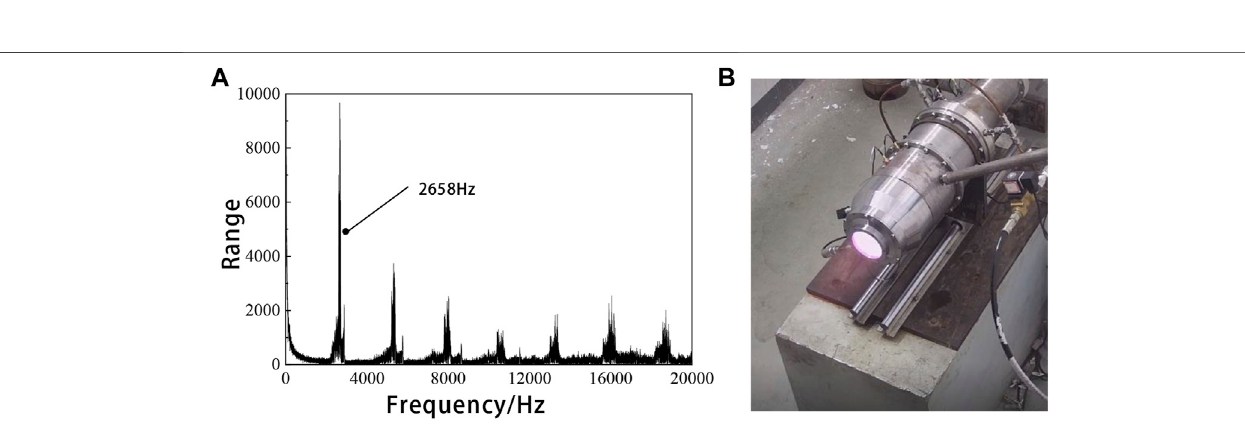
Frontiers in Energy Research |